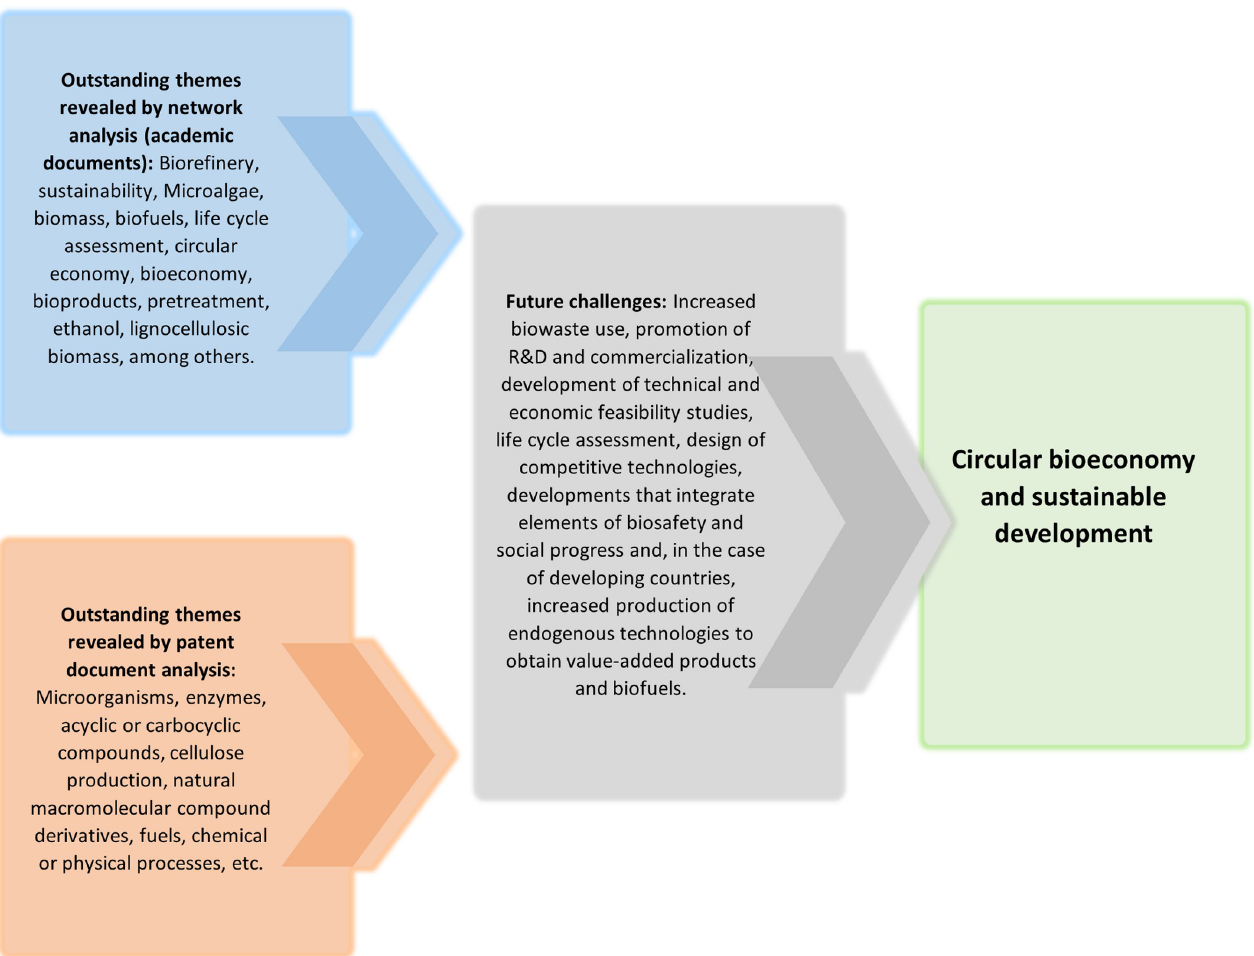
Fig 6. Biorefining, bioproducts, and biofuels. Source: Prepared by the authors.